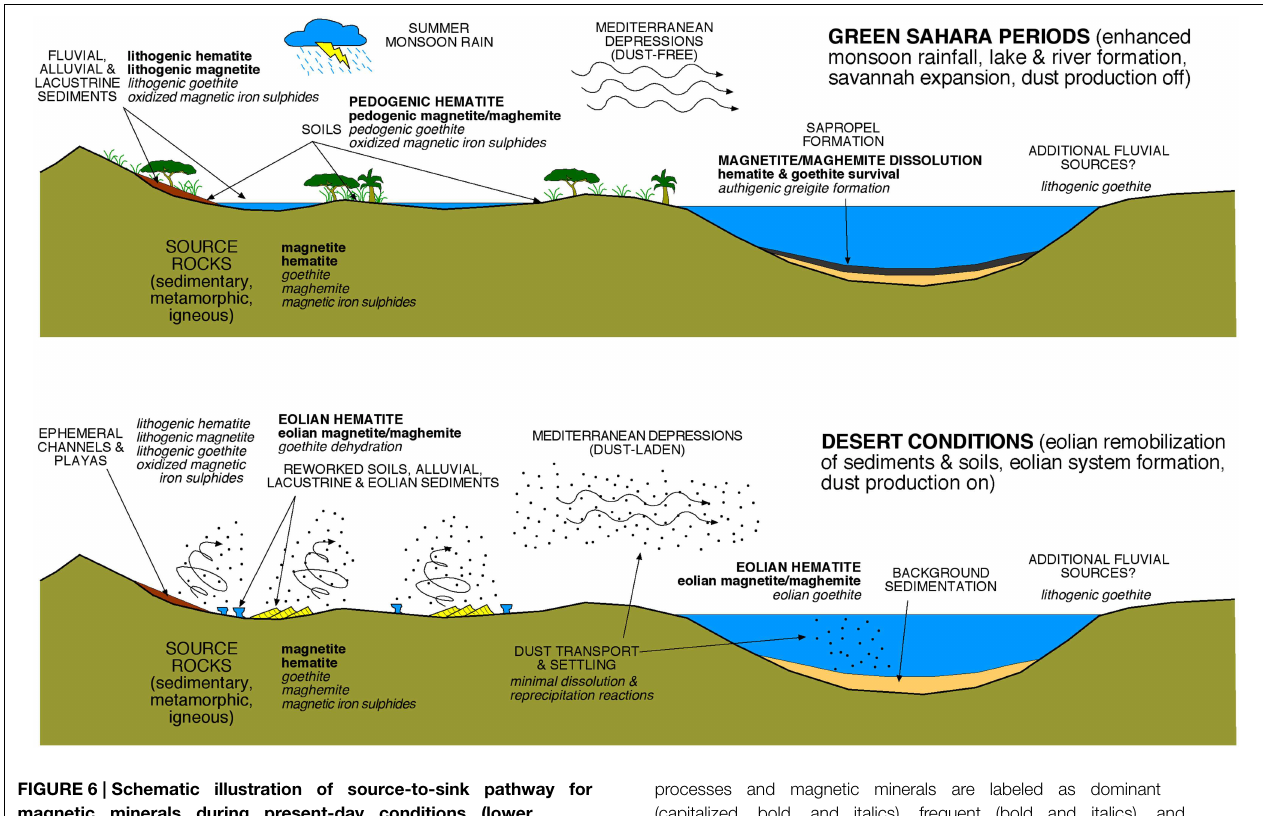
FIGURE 6 | Schematic illustration of source-to-sink pathway for magnetic minerals during present-day conditions (lower panel) and Green Sahara Periods (upper panel). Different